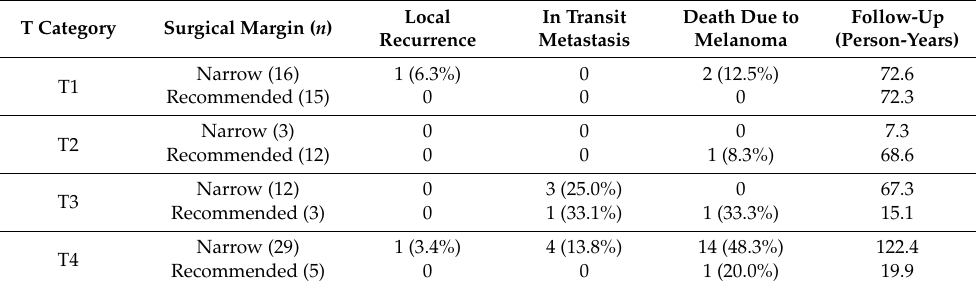
Table 3. Treatment outcome after follow-up of 95 patiens with stage I–III diseases.